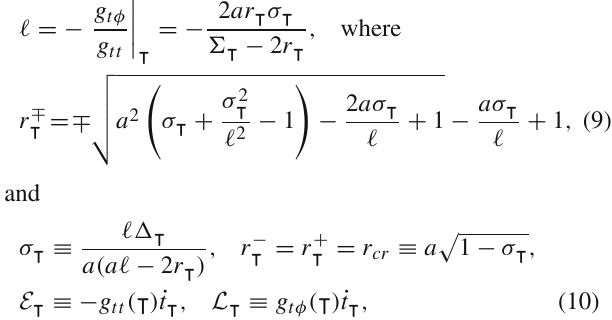
Counter-rotating tori ((cid:6) < 0 ) Co-rotating tori ( (cid:6) >